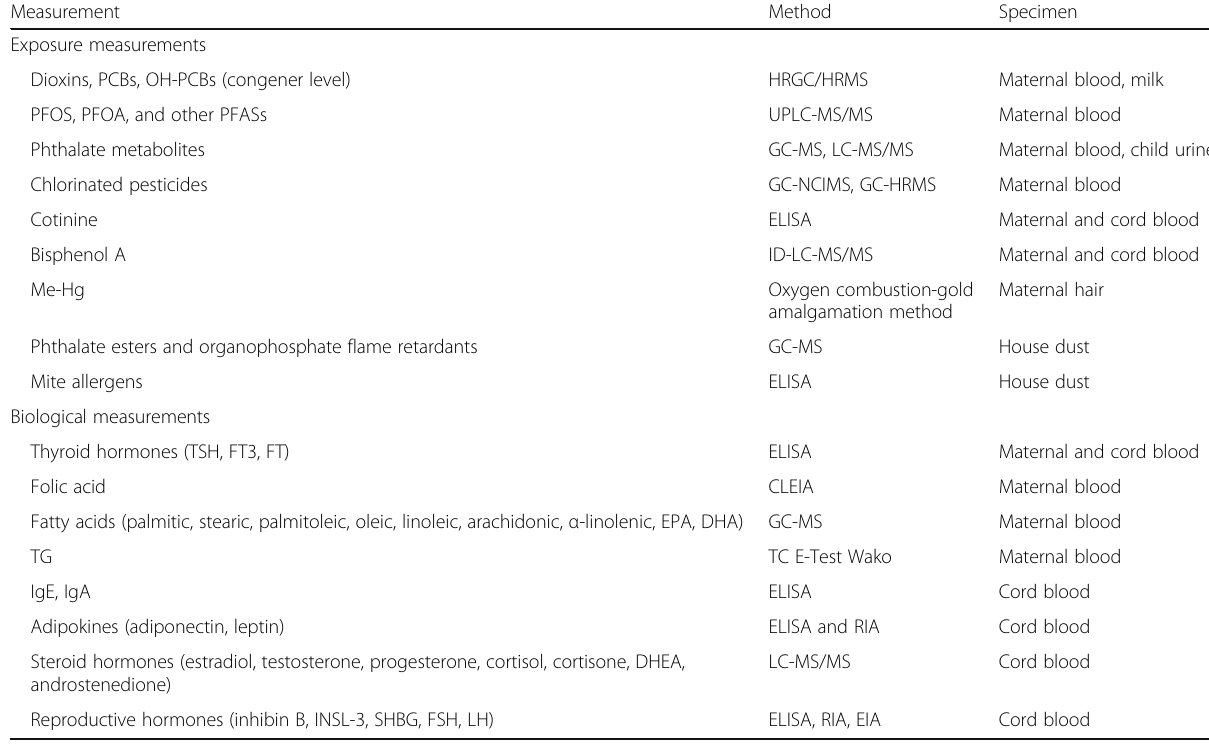
Table 2 Items measured in The Hokkaido Study on Environment and Children ’ s Health